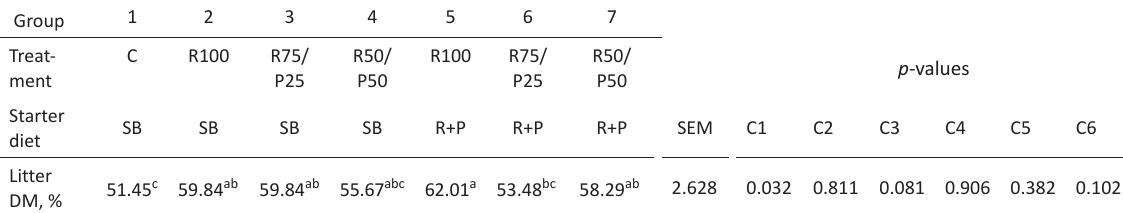
Table 8. The effect of diets with soybean (SB) meal, rapeseed meal (R), or rapeseed meal and peas (P) on mean litter dry matter (DM) Group